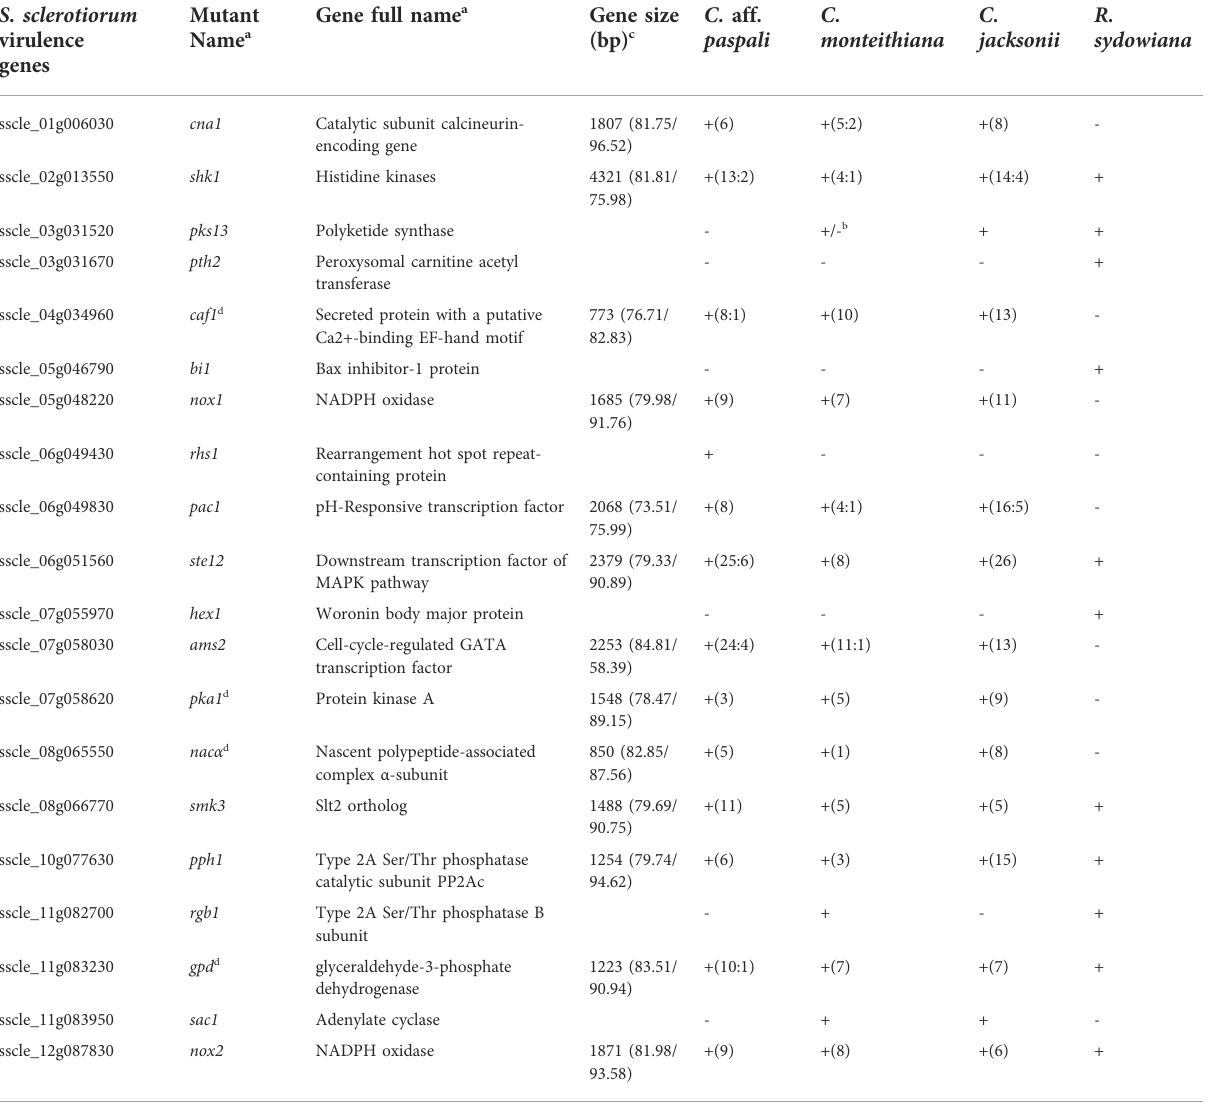
TABLE 2 Summary of S. sclerotiorum orthologs involved in pathogen morphogenesis and pathogenesis identi fi ed in C. aff. paspali and their genetic variation between Clarireedia species. S.